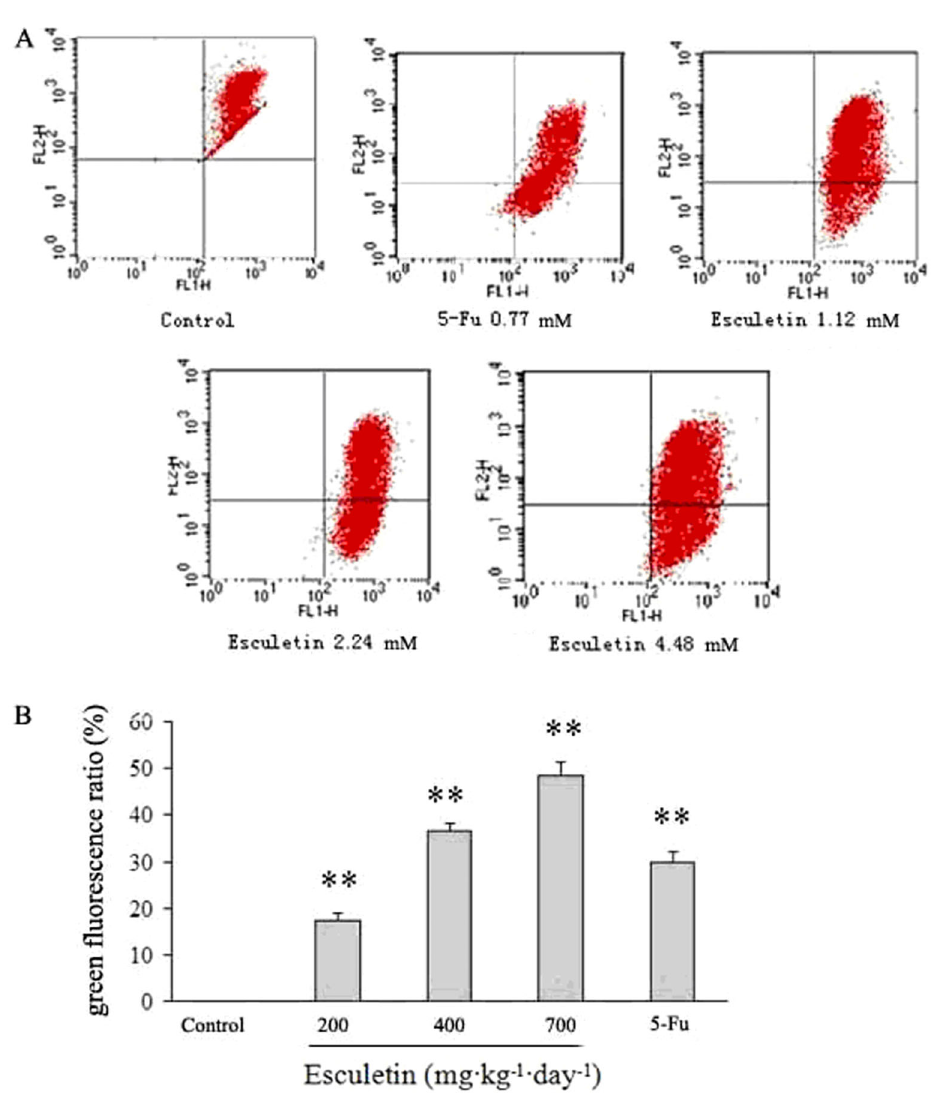
Figure 4. Esculetin caused loss of mitochondrial potential in SMMC-7721 cells ( A ) and in vivo ( B ). Mitochondrial membrane potential (MMP, DY m) was determined by flow cytometry analysis with JC-1 staining. Data were analyzed using the Bioconsort software and are reported as mean±SD for n=15. **P , 0.01 vs control group (one-way ANOVA followed by Bonferroni’s